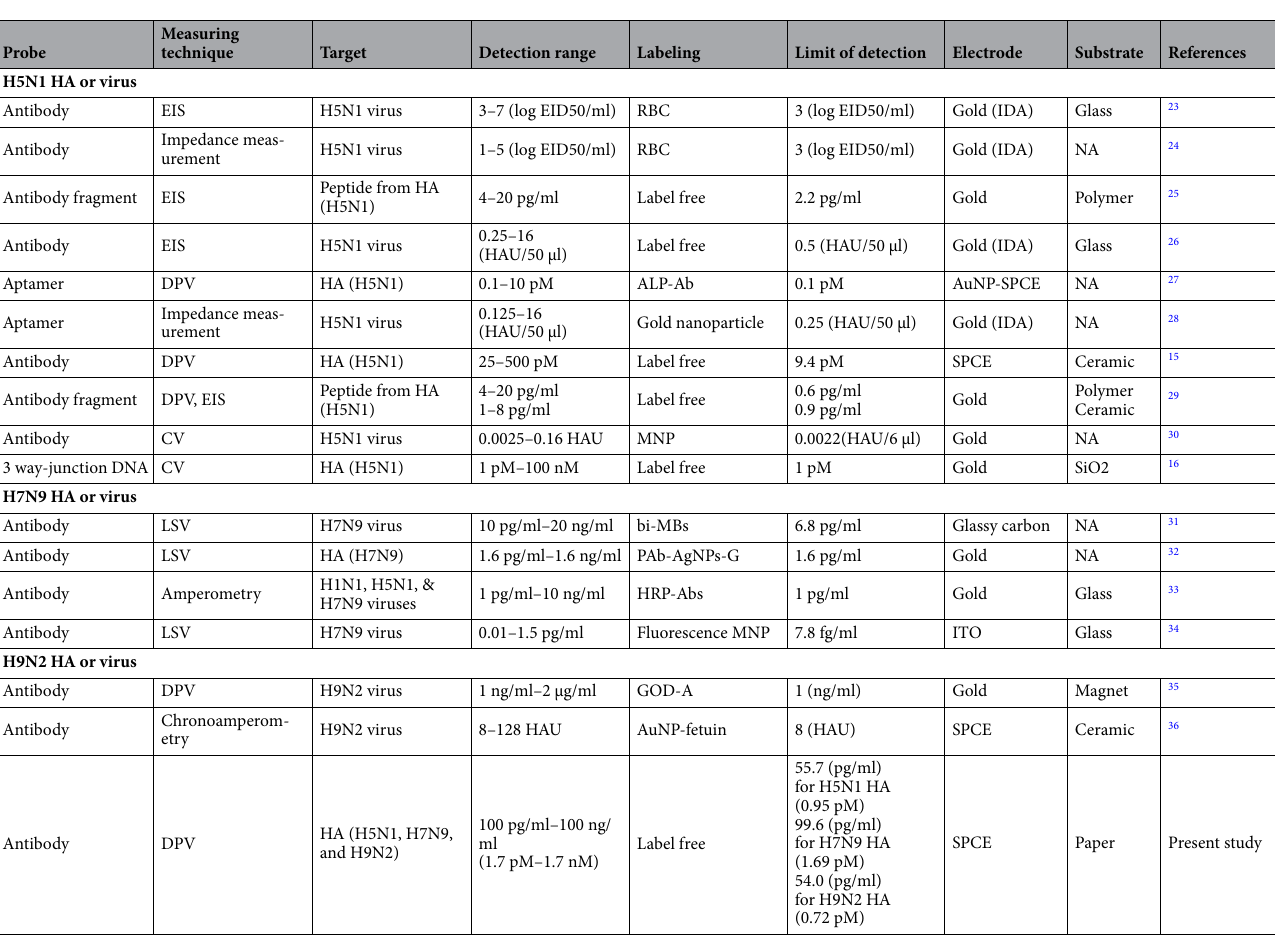
Table 1. Electrochemical immunosensors for detection of avian influenza viruses (H5N1, H7N9, and H9N2), their hemagglutinin (HA) proteins, or peptides derived from the hemagglutinin proteins. IDA